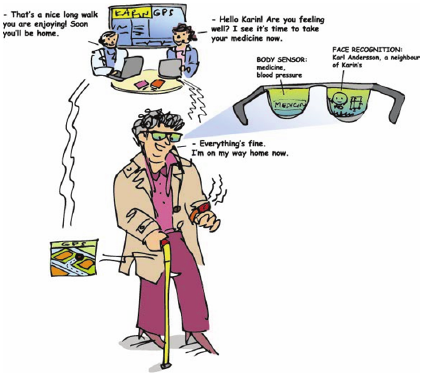
Figure 3: Mobile health applications in the